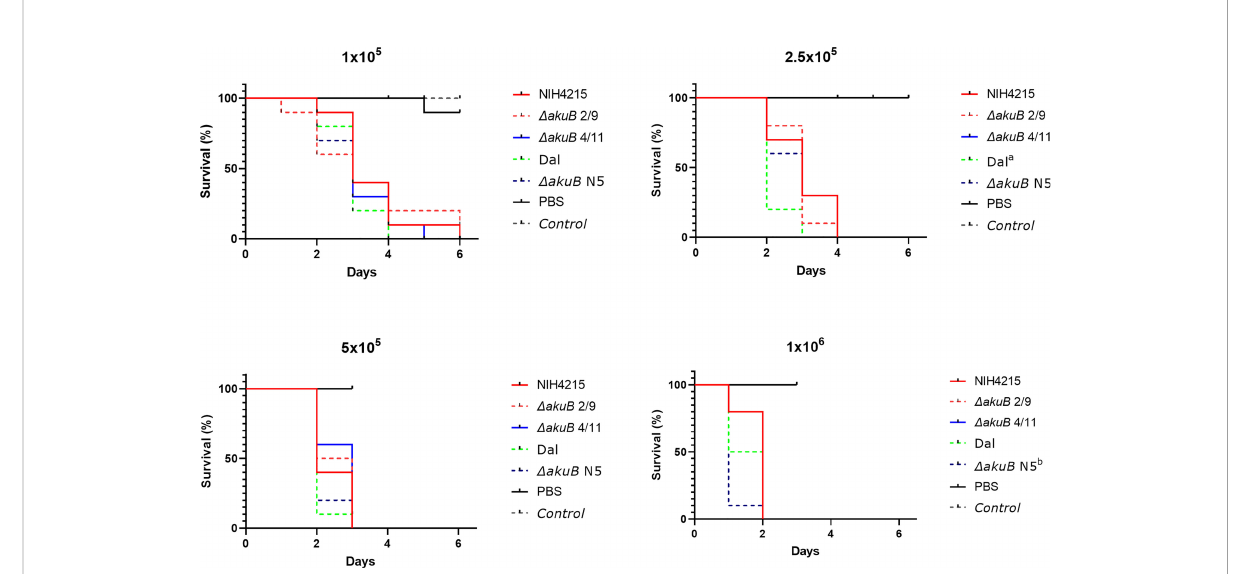
FIGURE 7 Virulence analysis of NIH4215 and nmt1 -complemented bioluminescent D akuB strains. Kaplan-Meier survival curves of Galleria mellonella larvae infected with A. fumigatus wild-type strains NIH4215 and CBS144.89 (Dal) and the corresponding bioluminescent D akuB mutants ( D akuB N5 for Dal; D akuB 2/9 and D akuB 4/11 for NIH4215). Each larva was injected with 50 µl of PBS or 50 µl PBS containing either 1 × 10 5 , 2.5 × 10 5 , 5 × 10 5 or 1 × 10 6 conidia of the individual strains. A group of untreated larvae was included as general viability control (Control). Signi fi cant differences in survival rates was tested by log-rank analysis. The NIH4215 wild type and its D akuB 2/9 and D akuB 4/11 strains did not signi fi cantly differ in their killing rate over the range of conidia concentrations tested. In the survival curve at 2.5 × 10 5 conidia/larva the Dal strain showed a signi fi cant difference compared to the NIH4215 strain indicated by a ( p = 0.0149). At 2.5 × 10 5 conidia/larva the D akuB N5 strain differed signi fi cantly to the Dal strain ( p = 0.0331) and at 1 × 10 6 conidia/larva to strain NIH4215 ( p = 0.0022) as indicated by b